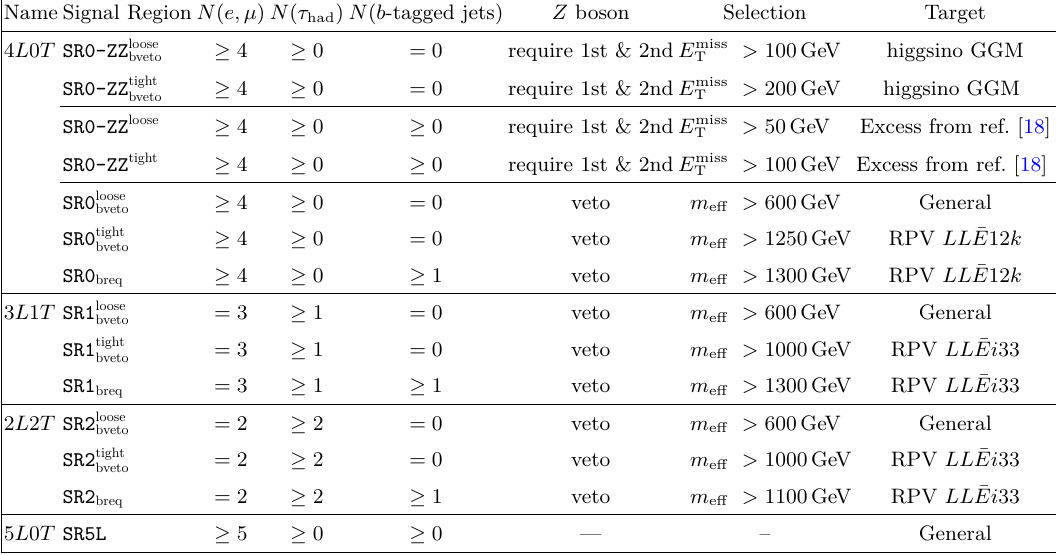
Table 4. Signal region definitions. The Z boson column refers to the Z veto or selection of a first and second Z candidate as described in the